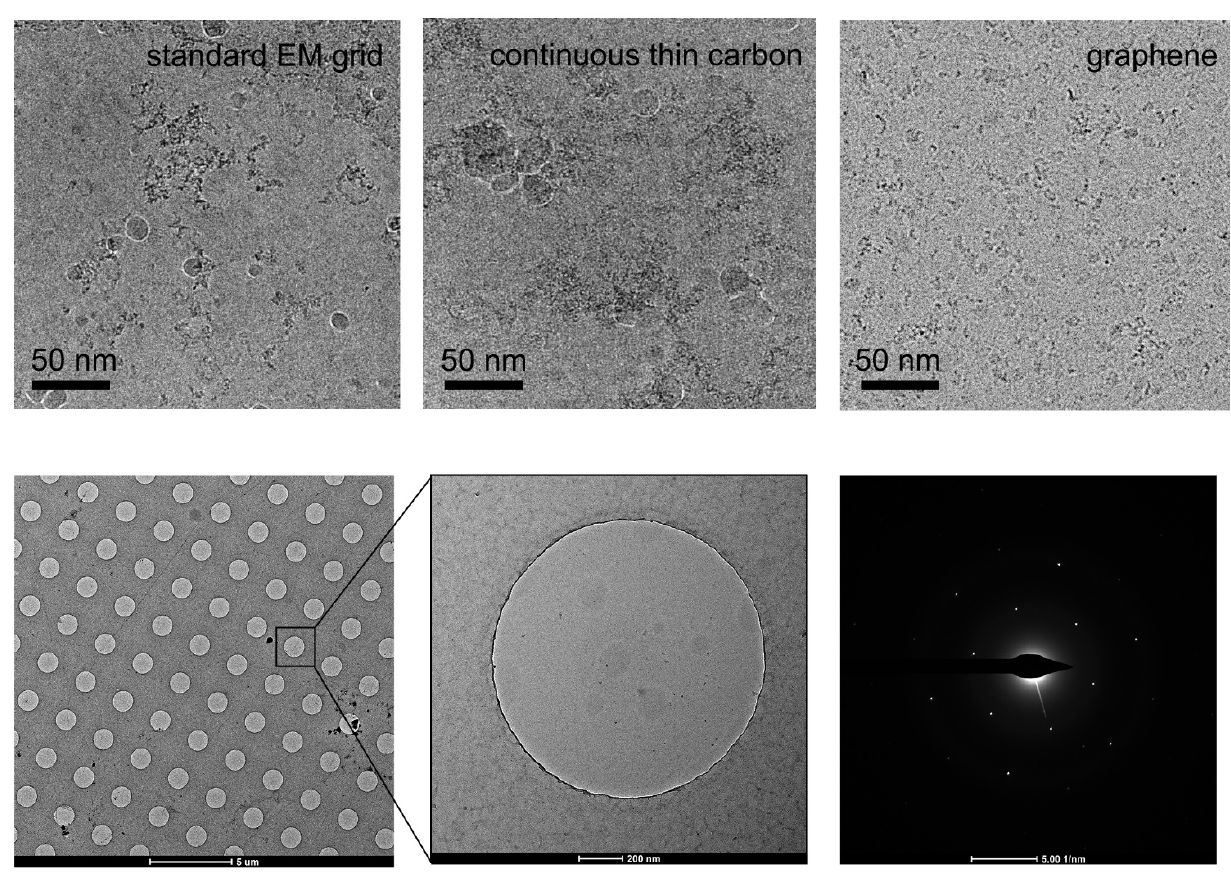
Figure 4. Improvement of graphene grid on the protein distribution by preventing from adsorption to the AWI. The graphene grid examined in the diffraction mode before sample preparation showed single-layer coverage.